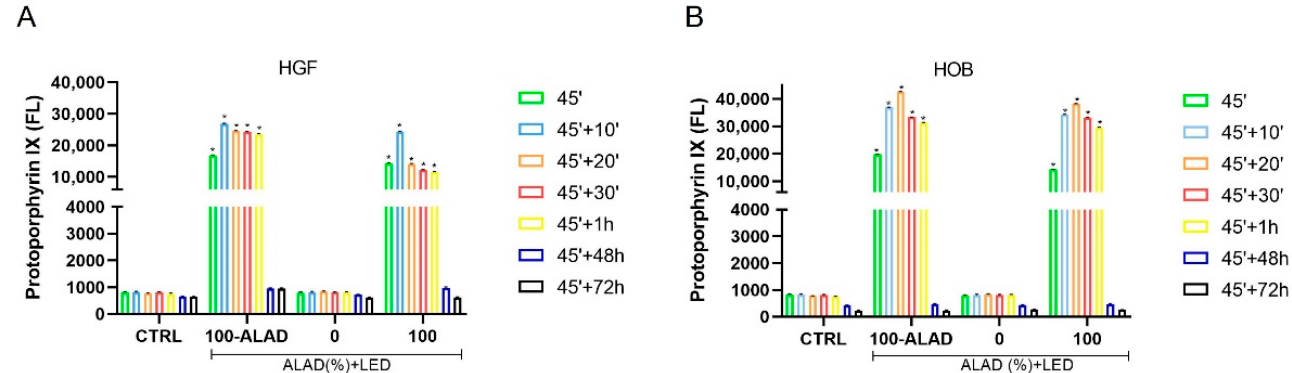
Figure 5. Levels of intracellular PpIX. Fluorescence of PpIX was measured ( λ ex = 405 nm; λ em = 608 λ em = 608 nm) immediately after the end of ALAD-PDT (45 (cid:48) ) and after 10 min (45 (cid:48) + 10 (cid:48) ), 20 nm) immediately after the end of ALAD-PDT (45 ′ ) and after 10 min (45 ′ + 10 ′ ), 20 min (45 ′ + 20 ′ ), 30 min (45 ′ + 30 ′ ), 1 h (45 ′ + 1 h), 48 h (45 ′ + 48 h) and 72 h (45 ′ + 72 h). Data are presented as mean ± SD